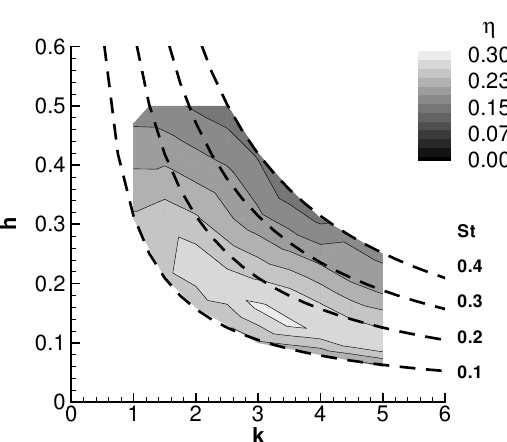
Figure 9. Propulsive efficiency with Re = 17,000.